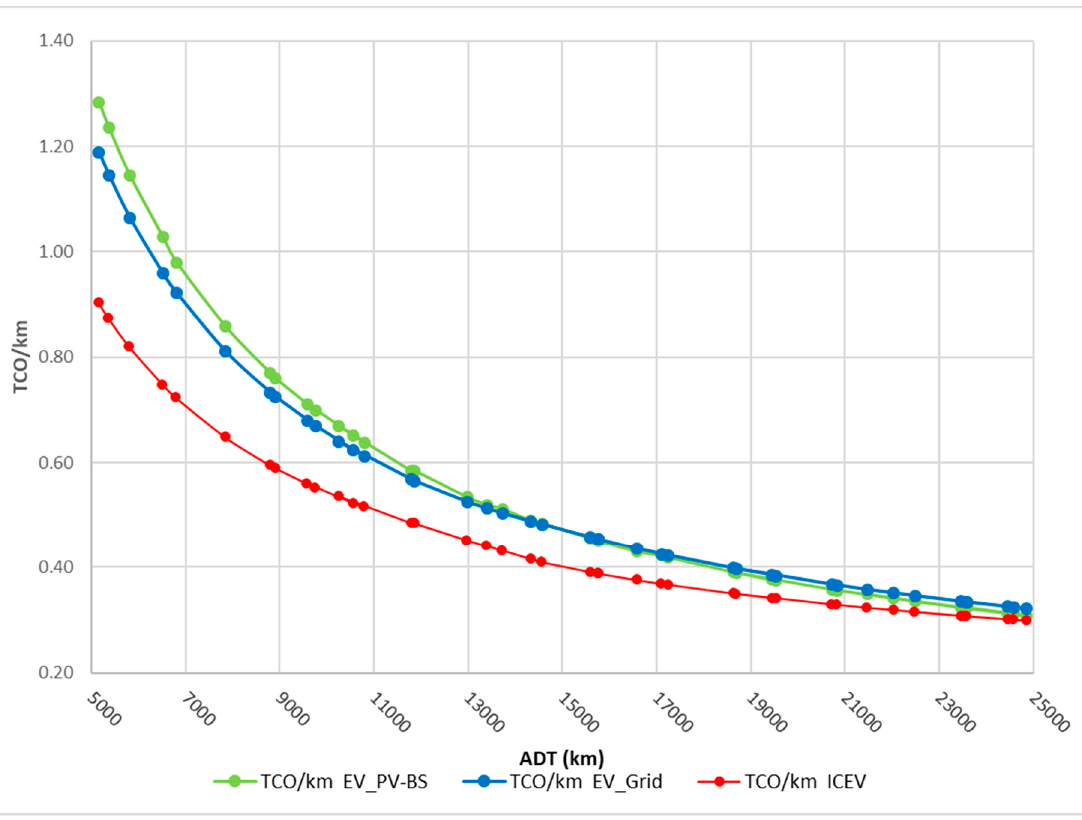
Figure 10. TCO/km in Scenario 2 with varying ADT. Figure 10. TCO / km in Scenario 2 with varying